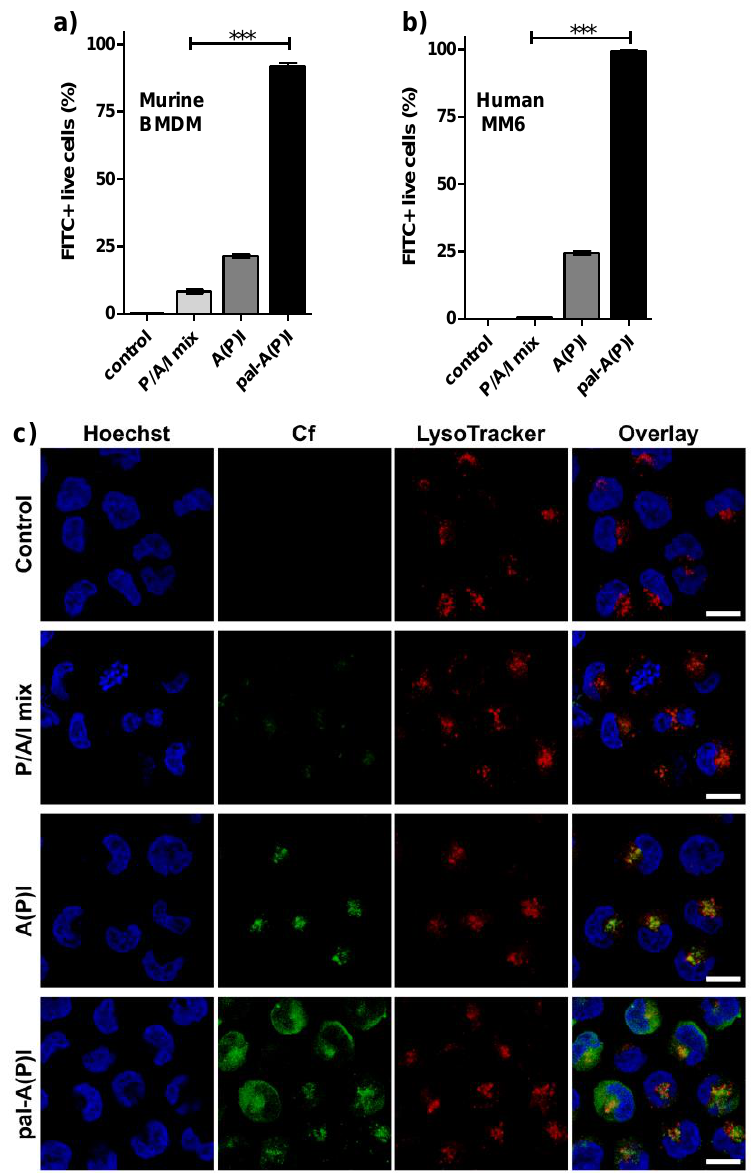
Figure 2. The internalization of Cf -labelled epitope peptides and conjugates ( P/A/I mix, A(P)I, pal-A(P)I ) was studied on ( a ) murine bone marrow-derived macrophages (BMDMs) and ( b ) MonoMac6 human monocytes (MM6) by using flow cytometry. ( c ) Localization of the compounds in MM6 cells were visualized by confocal laser scanning microscopy. Cells were incubated with Cf- labelled peptides (green), lysosomes were stained with LysoTracker Deep Red (red), nuclei were stained with Hoechst 33342 (blue). The scale bar represents 10 µm. (***: p < 0.001). To accurately quantify the internalization of the peptides and to distinguish surface-bound peptides from internalized ones, external fluorescence was either quenched with trypan blue or membrane-absorbed peptides were removed by trypsin. Trypsinization is used to dissociate adherent cells from the plate in which they were cultured and, in the meantime, cell surface proteins and surface bound compounds are also cleaved from the cells. Trypan blue dye is non-permeant to live cells and is reported to quench the extracellular green fluorescence signal [33]. Cellular uptake of trypsinized cells showed the same rate as non-trypsinized cells (Figure 3a), and the percentage of FITC positive